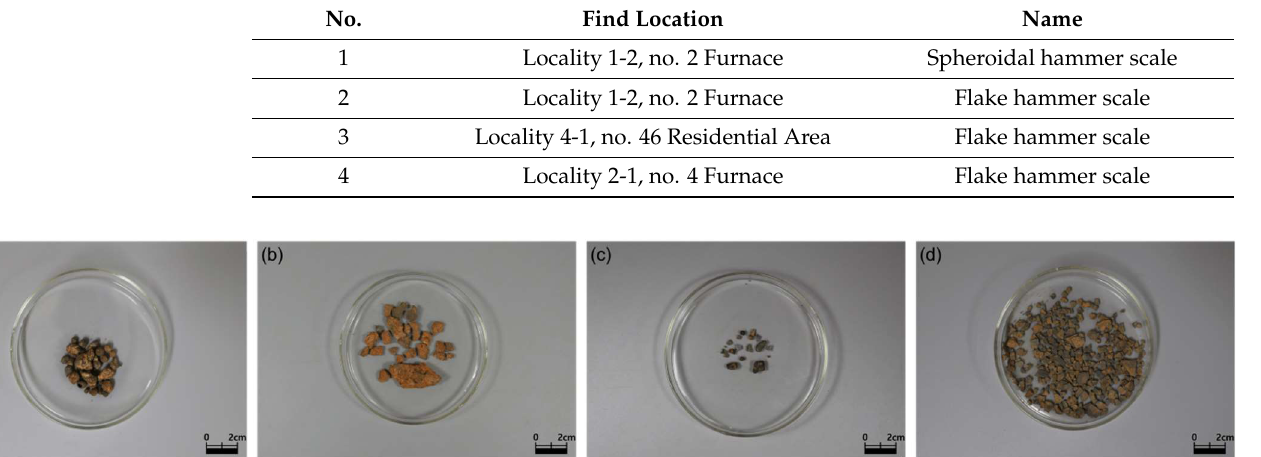
Table 1. List of flake samples excavated from the Jincheon Songduri site.